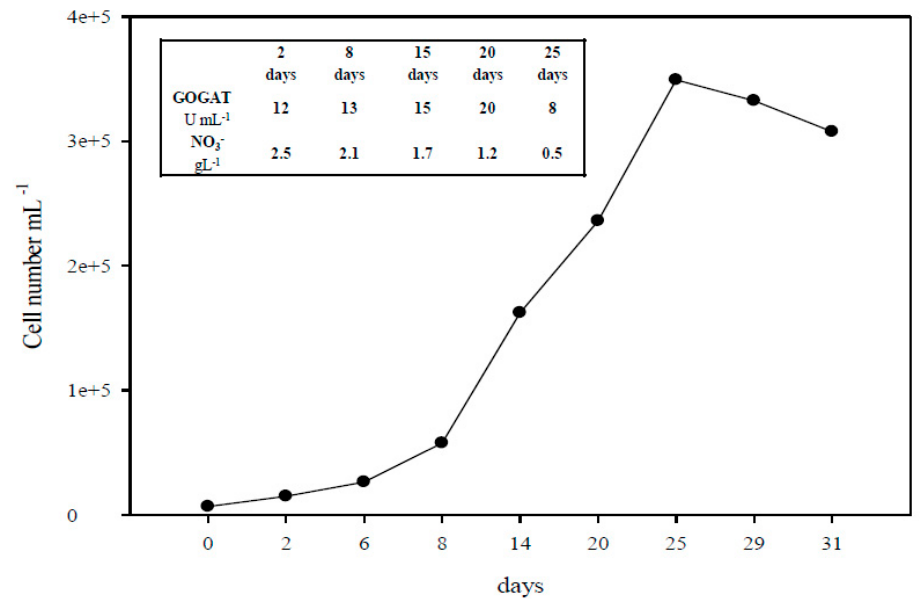
Figure 1. Cell growth curve, Glutamate Synthase (GOGAT) activity and nitrate depletion in the medium during the cultivation period.